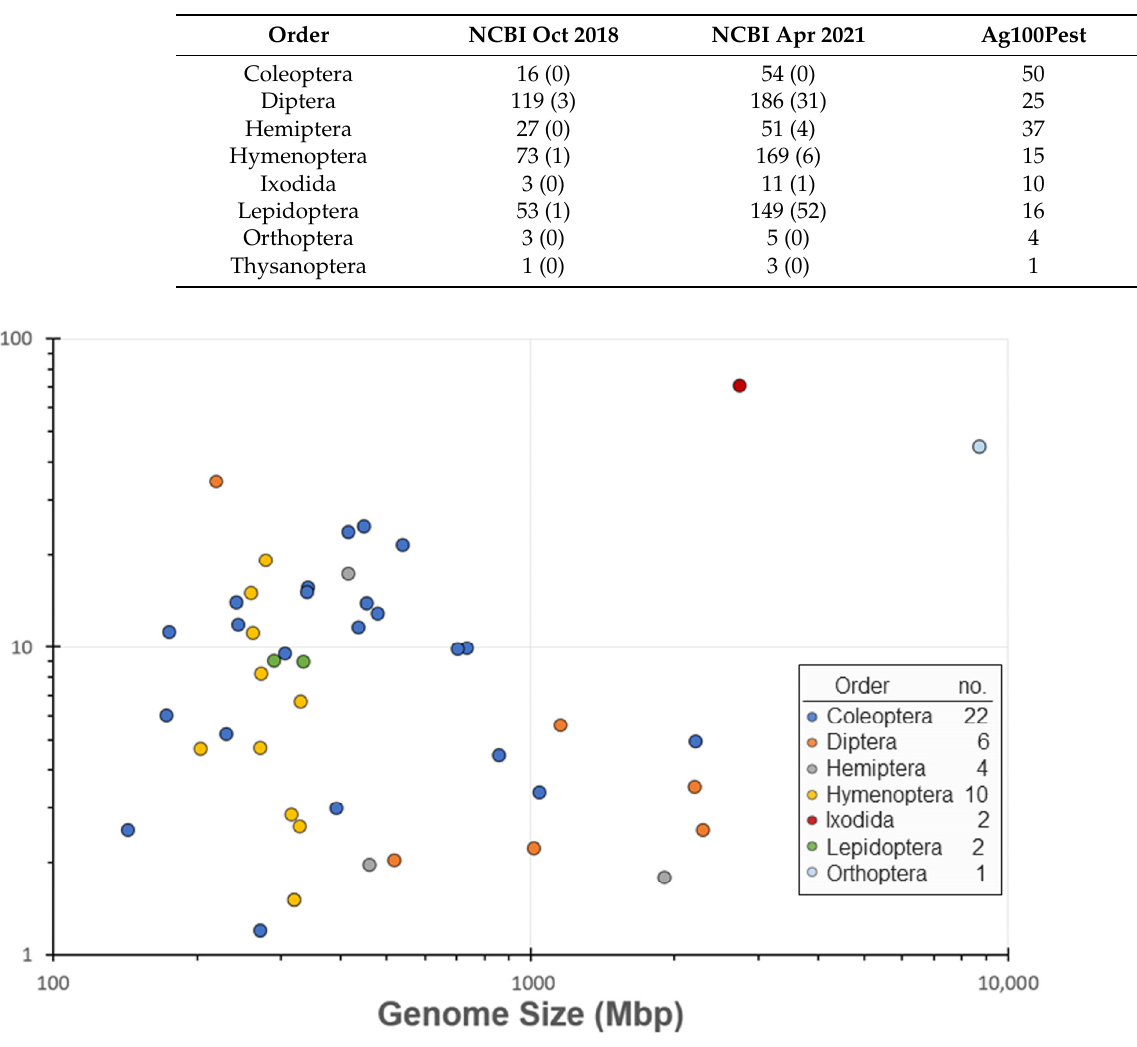
Table 1. Number of species with a genome assembly in NCBI or included in the Ag100Pest Initiative for eight orders in the phylum Arthropoda, covered by the Ag100Pest Initiative. NCBI data was accessed on 24 October 2018 and 27 April 2021, respectively. The number of species with a high- quality assembly in NCBI for each order is indicated in parentheses. Assemblies with a contig N50 of 1 Mbp or greater and scaffolding with an N50 of 10 Mbp or greater were deemed high-quality. Assemblies without clear scaffolding (scaffold N50 > contig N50) were not evaluated as high-quality.